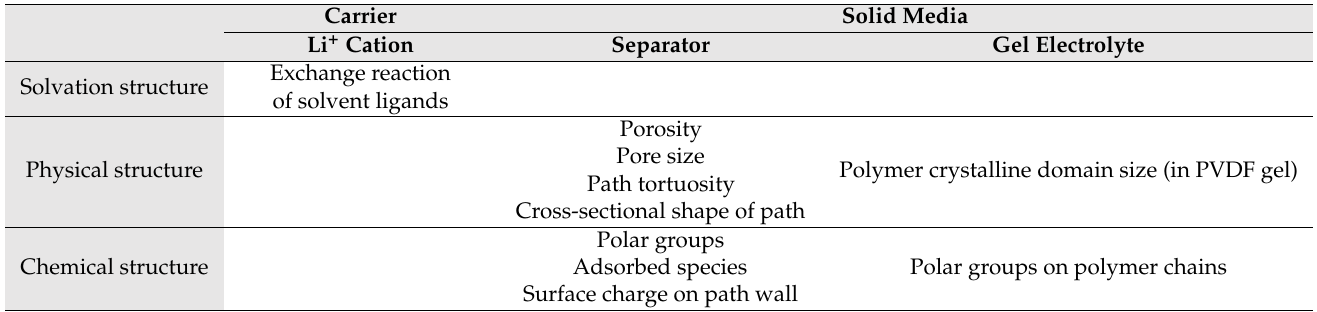
Table 1. Determining factors of ionic mobility in electrolytes in separator membranes and polymer gel